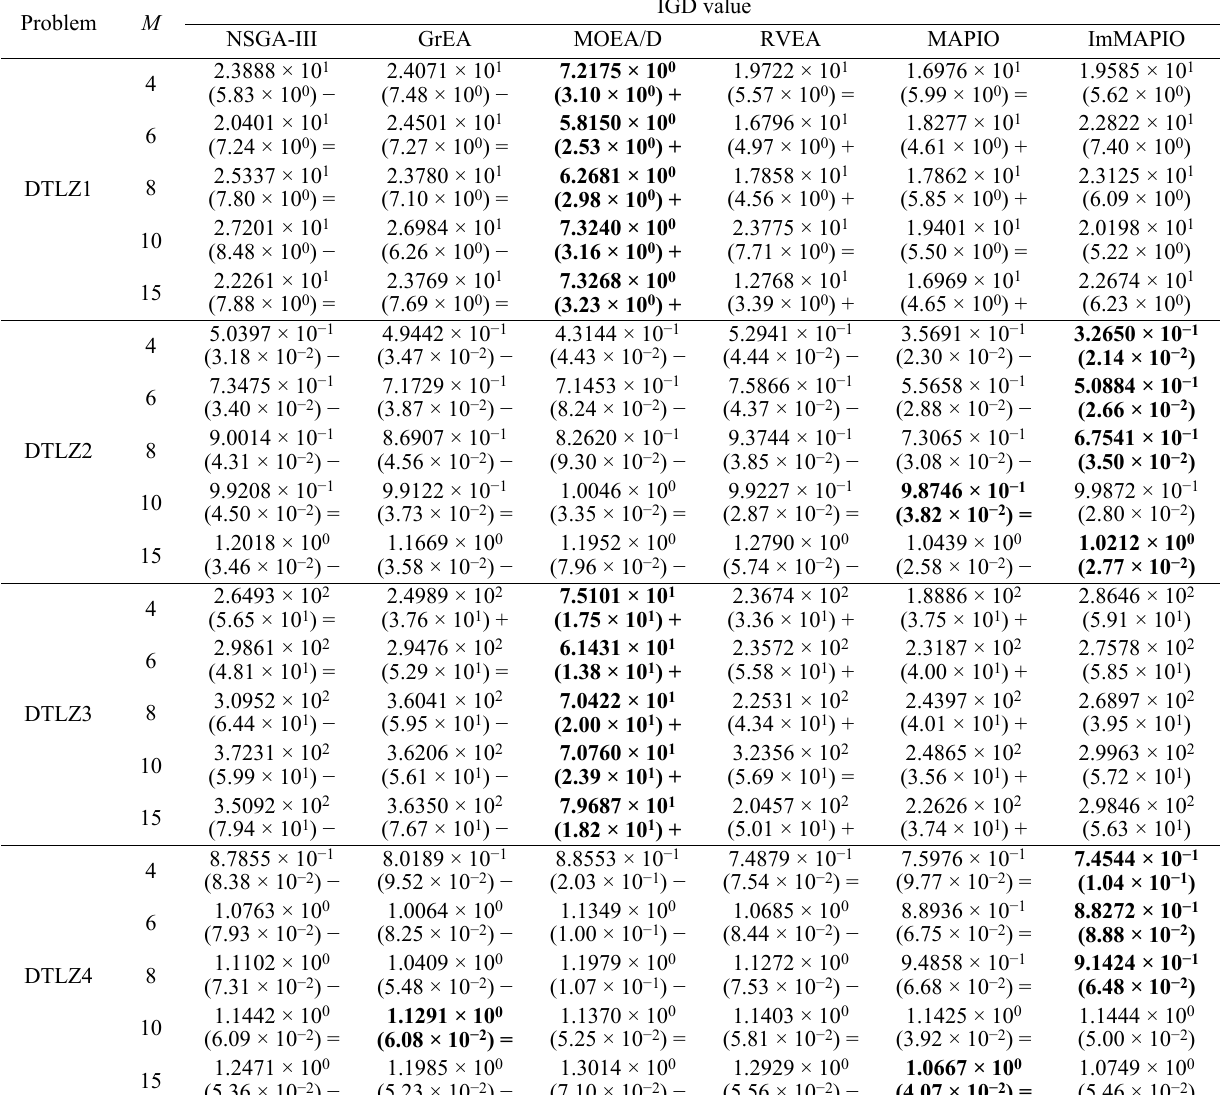
Table 3 IGD values of six algorithms for different objectives in the DTLZ test